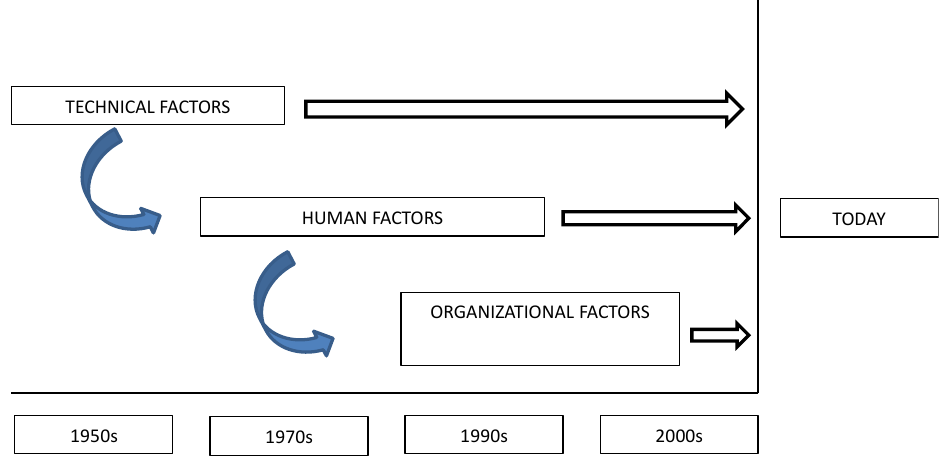
Figure 5. Safety evolution in aviation (from [30]).